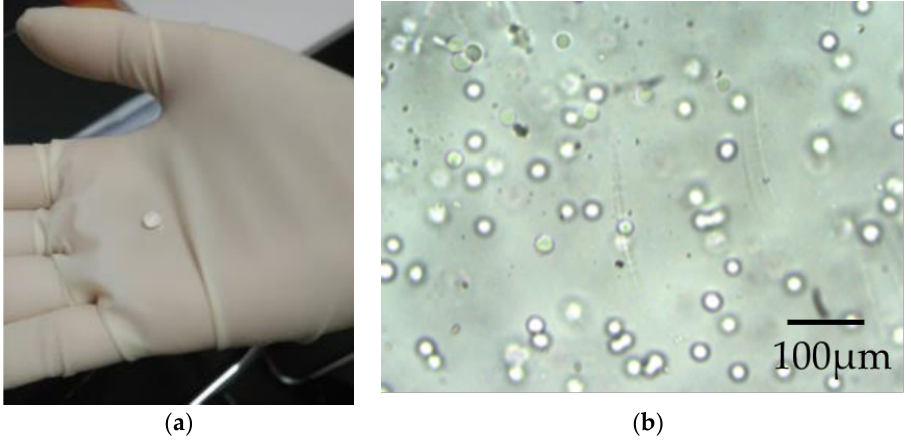
Figure A5. Picture of ( a ) a newly formed alginate bead; ( b ) NHAC-Kn in the alginate beads.